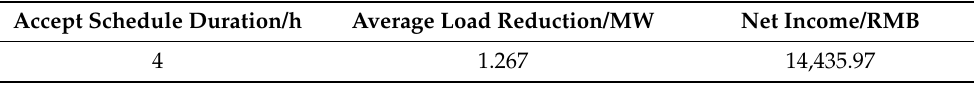
Table 3. Load reduction and aggregator income of air conditioning cluster under set conditions.